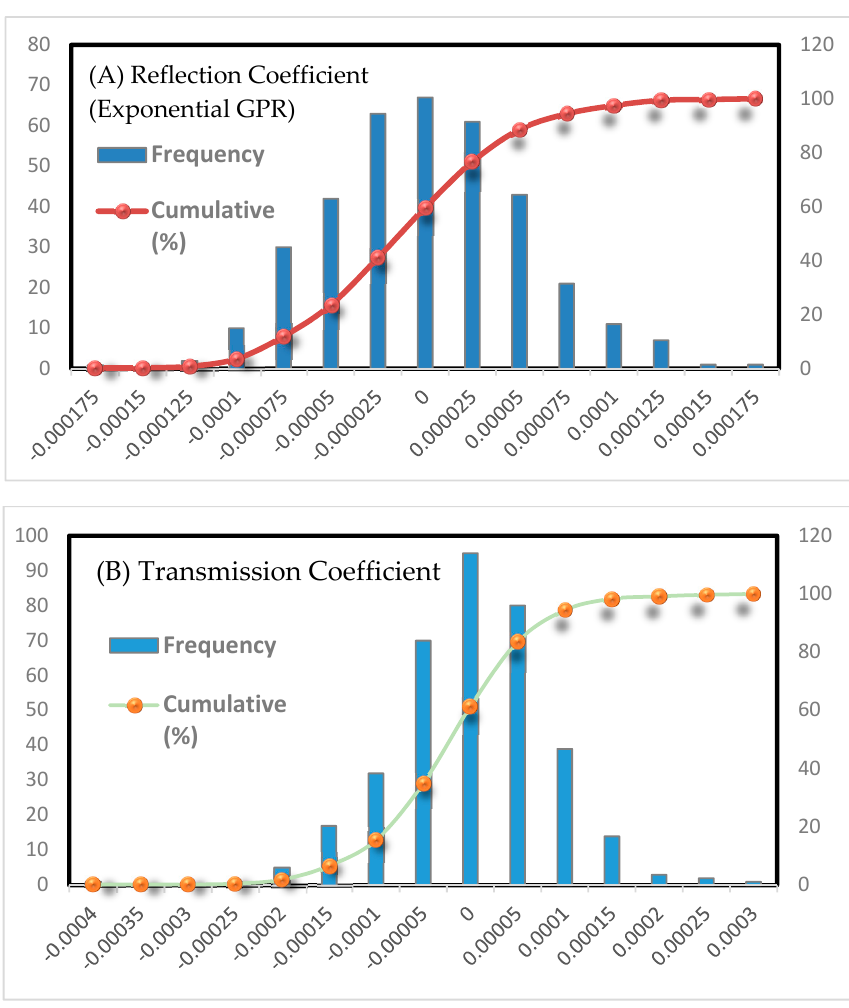
Figure 7. The error distribution of predicted and actual values for ( A ) Reflection Coefficient parameter ( B ) Transmission Coefficient parameter.